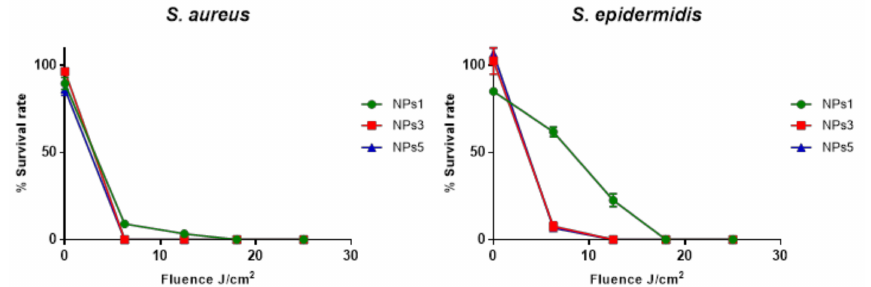
Figure 1. Photodynamic inactivation of S. aureus and S. epidermidis depending on the light